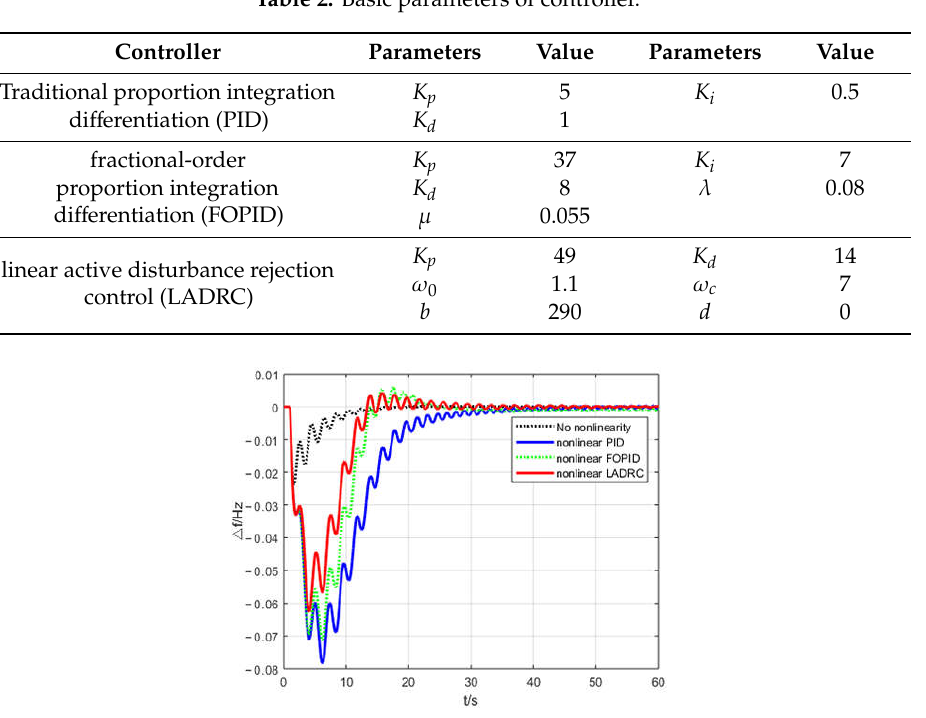
Table 2. Basic parameters of controller.